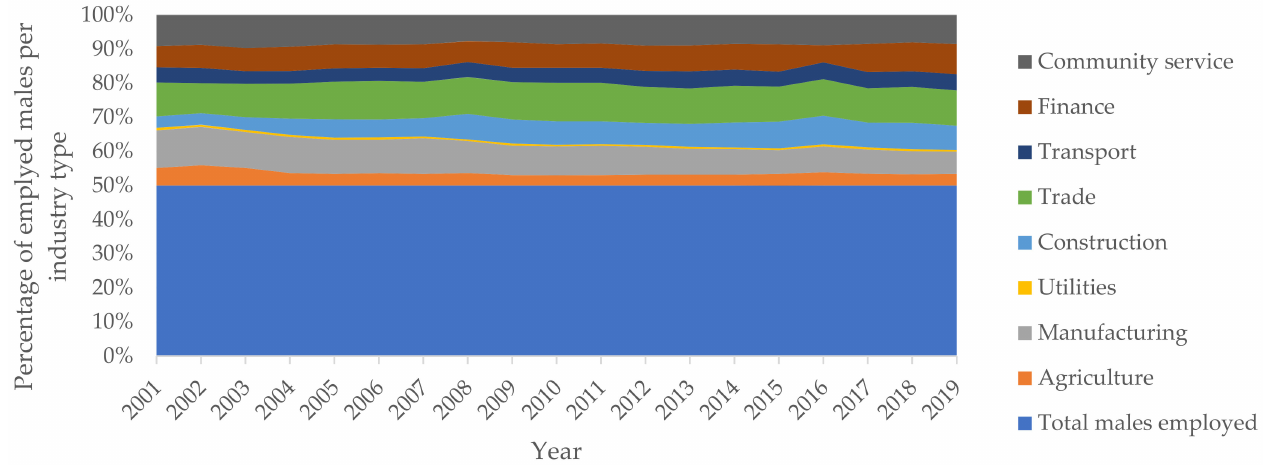
Figure 3. Male employment in South Africa (excludes mining, private